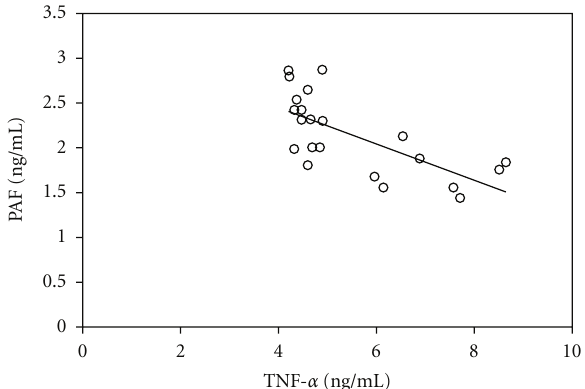
Figure 2: Relativity analysis of TNF- α and PAF in leukocytospermia